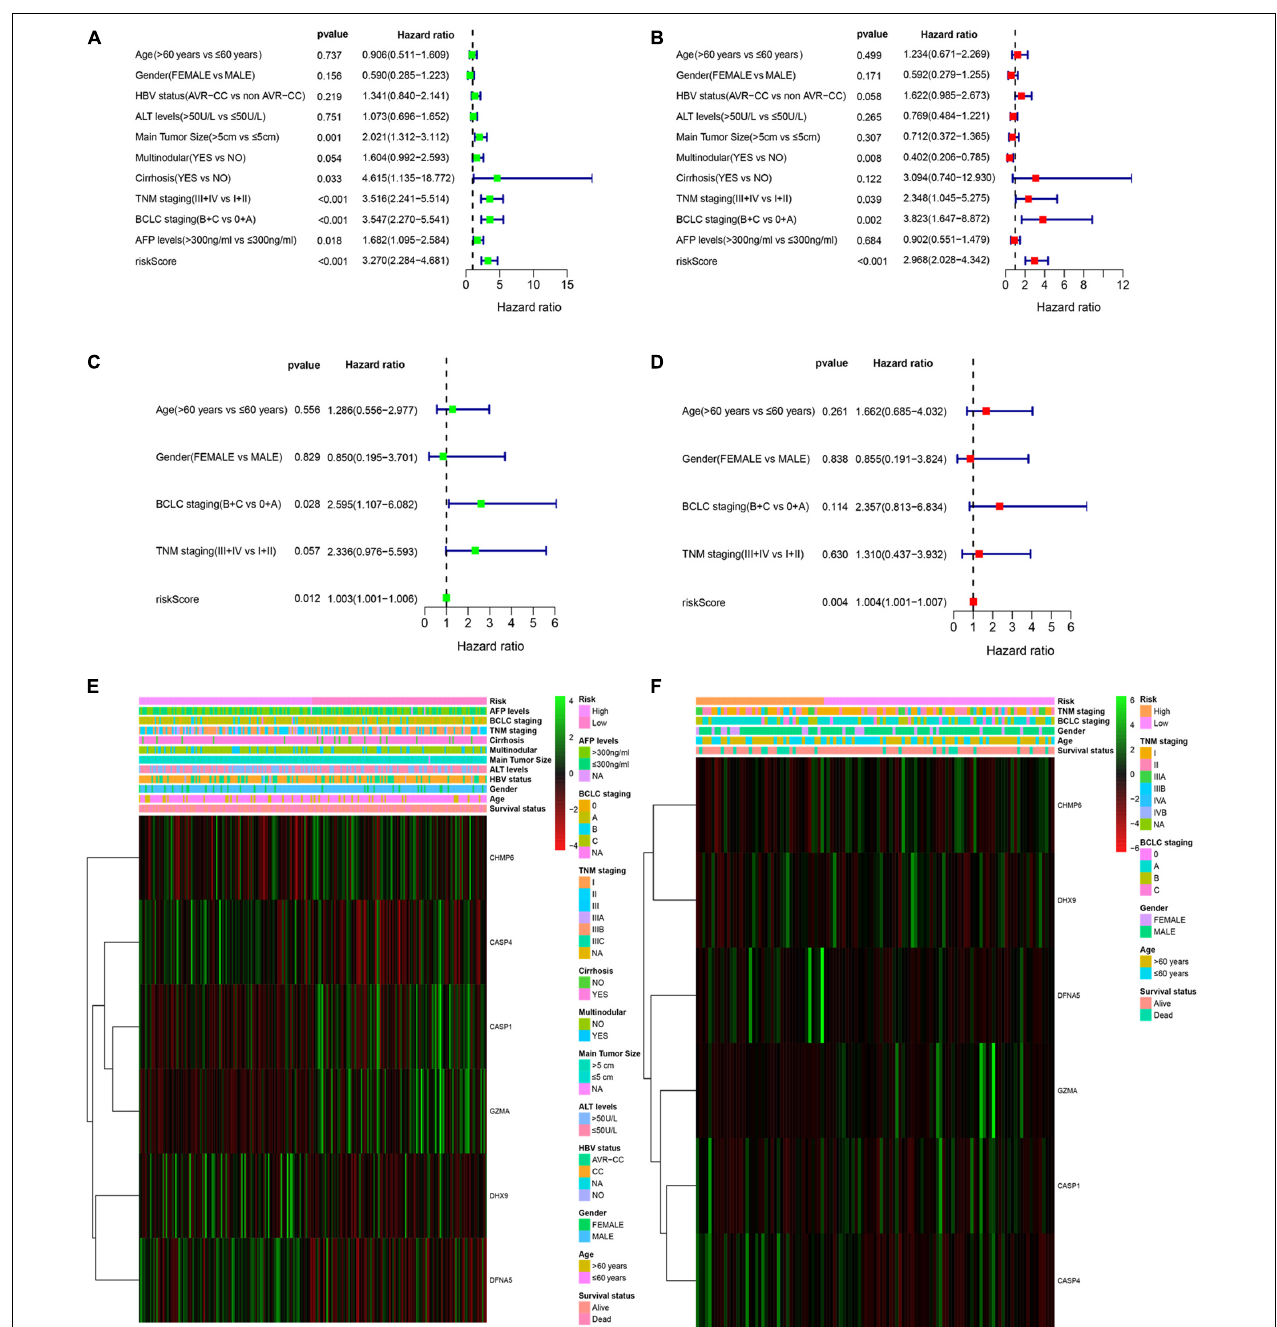
FIGURE 4 | Independent prognostic value of the PRG risk model. (A,B) Univariate (A) and multivariate Cox (B) analyses in the training cohort. (C,D) Univariate (C) and multivariate Cox (D) analyses in the validation cohort. (E,F) Heatmap of the six-pyroptosis-related gene profile and clinical features in two subgroups for the training (E) and validation (F)